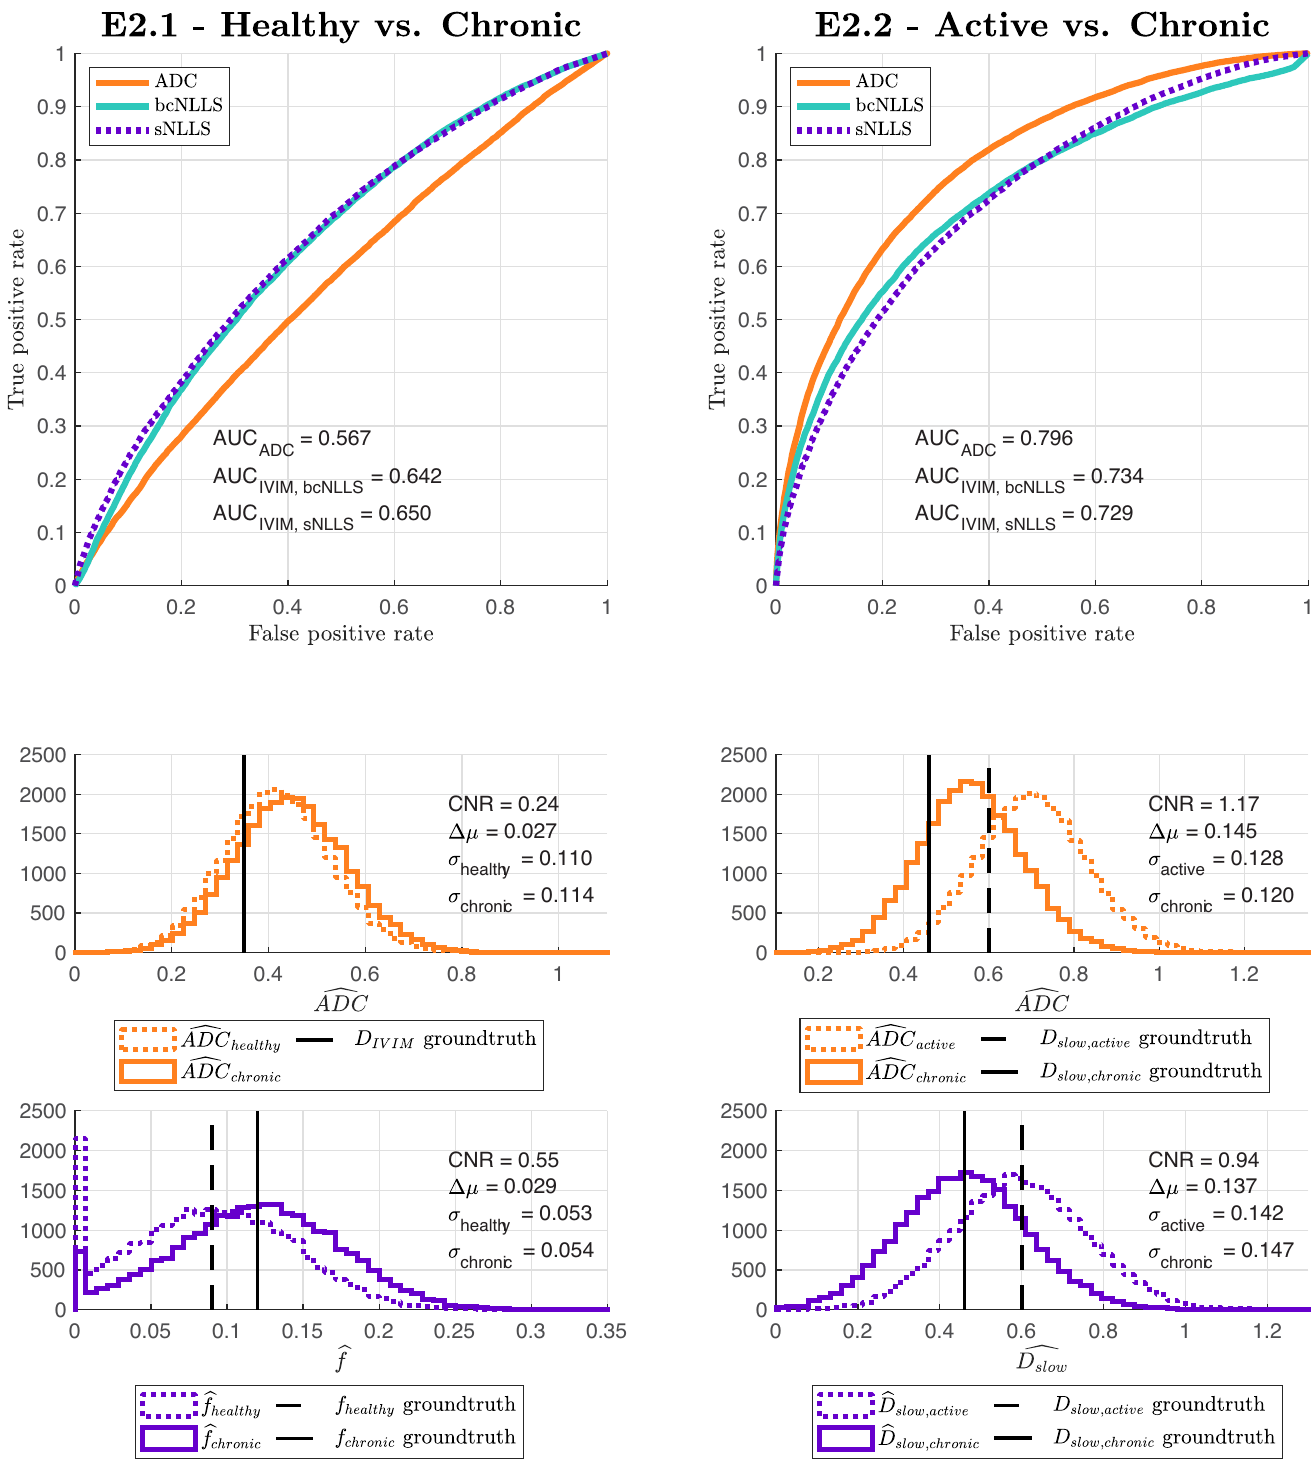
Fig 4. ROC curves and associated AUC values for two illustrative classification tasks, together with the distributions of parameter estimates underlying these ROC curves. Despite IVIM being the generative model for both tasks, it is outperformed by ADC in Task E2.2. Within IVIM, sNLLS outperforms bcNLLS in Task E2.1; the opposite is true in Task